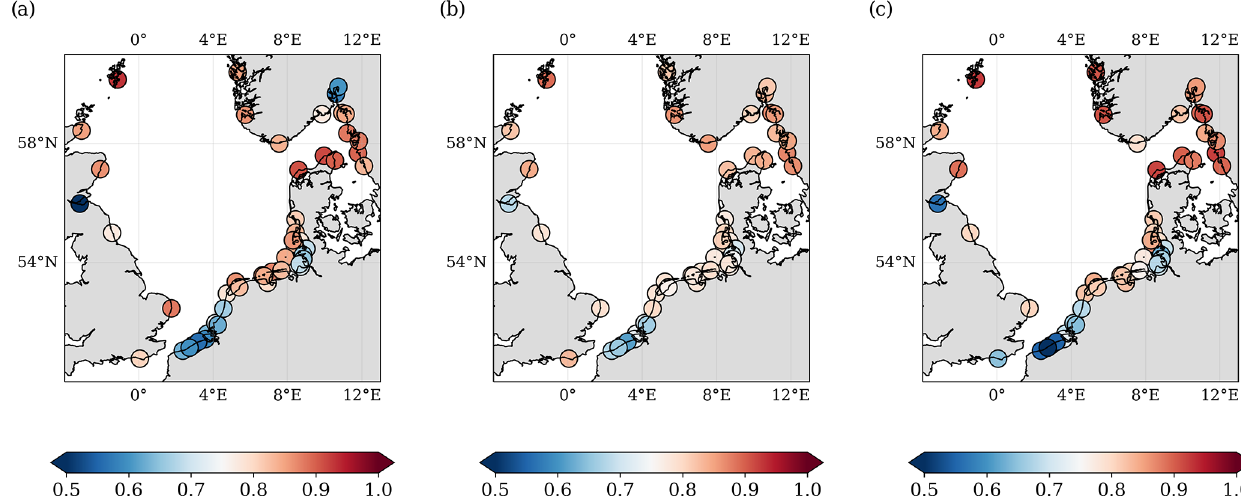
Figure A1. Correlations of altimetry sea level observations with 54 tide gauge observations computed over a period of 20 years (1995–2015) for three different altimetry datasets: (a) North SEAL, (b) CMEMS, and (c) SL_cci. The median correlations for all stations are 0.828 (North SEAL), 0.790 (CMEMS), and 0.816 (SL_cci) without taking into account quality flags of North SEAL SLA